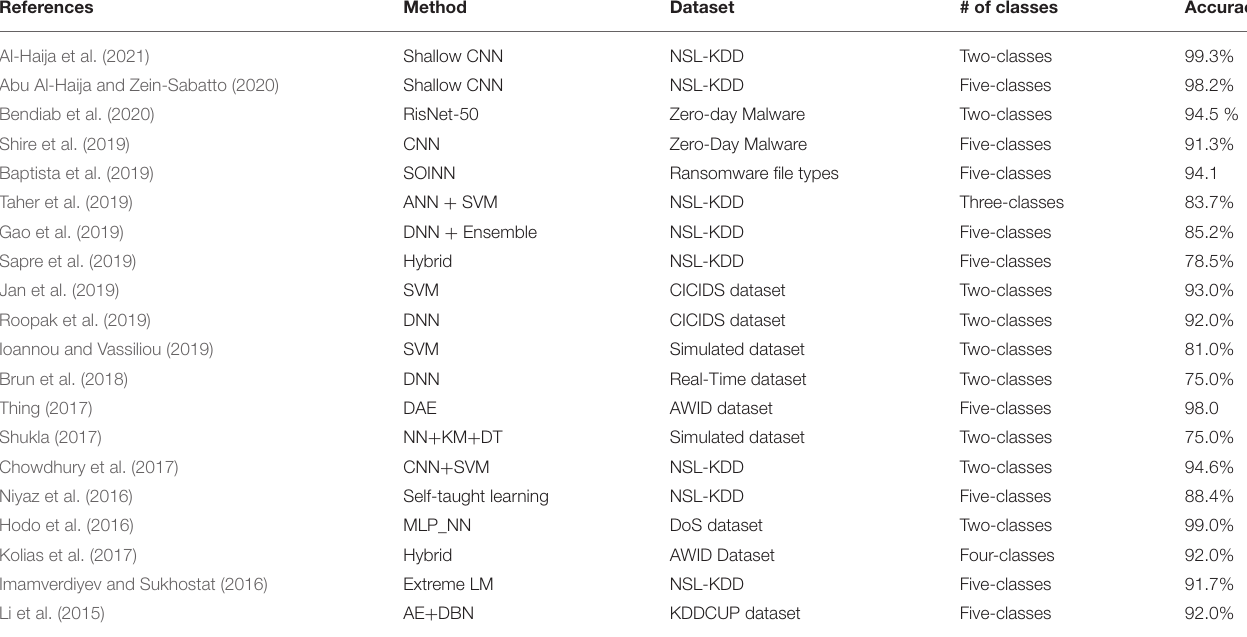
TABLE 1 | A summary of the related research for machine-learning-based IoT